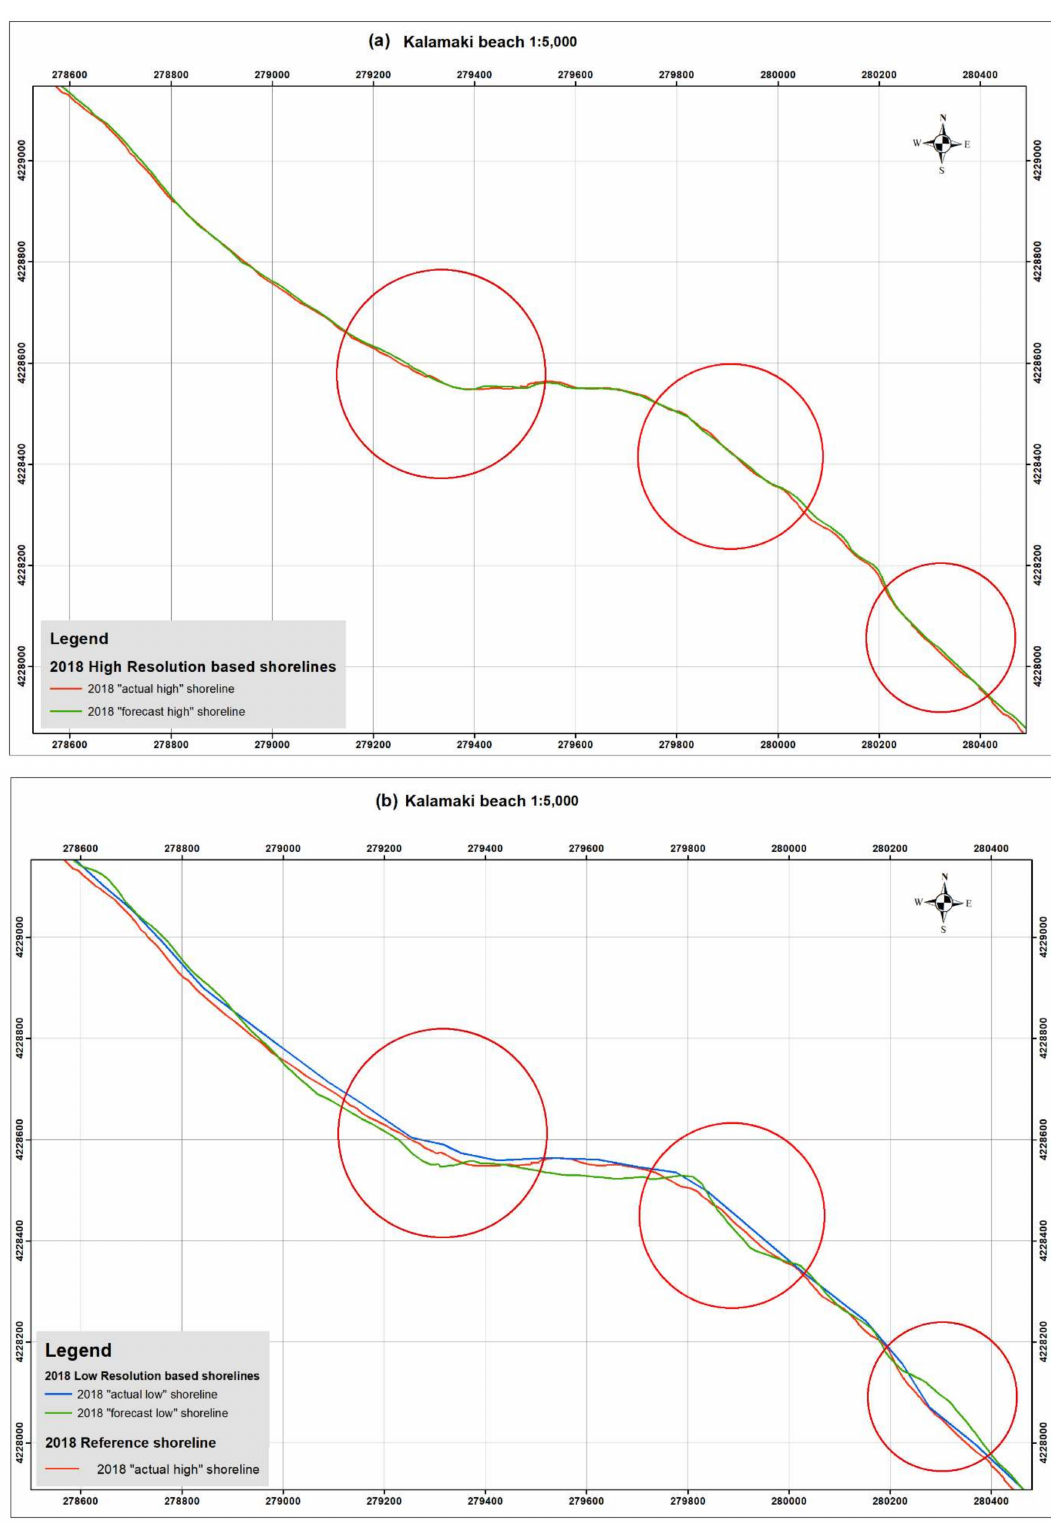
Figure 4. Shorelines of 2018 overlapping at a high scale based on ( a ) high- and ( b ) low-resolution images for Kalamaki beach. Red cycles demonstrate areas where the deviation in the low-resolution data is obvious in high-scale